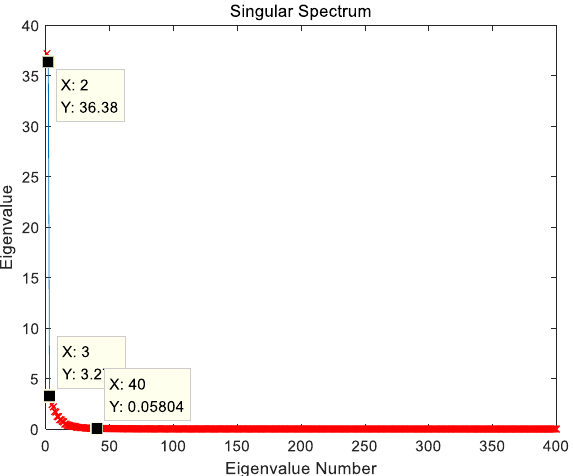
Figure 8. Singular value spectrum of trajectory matrix.